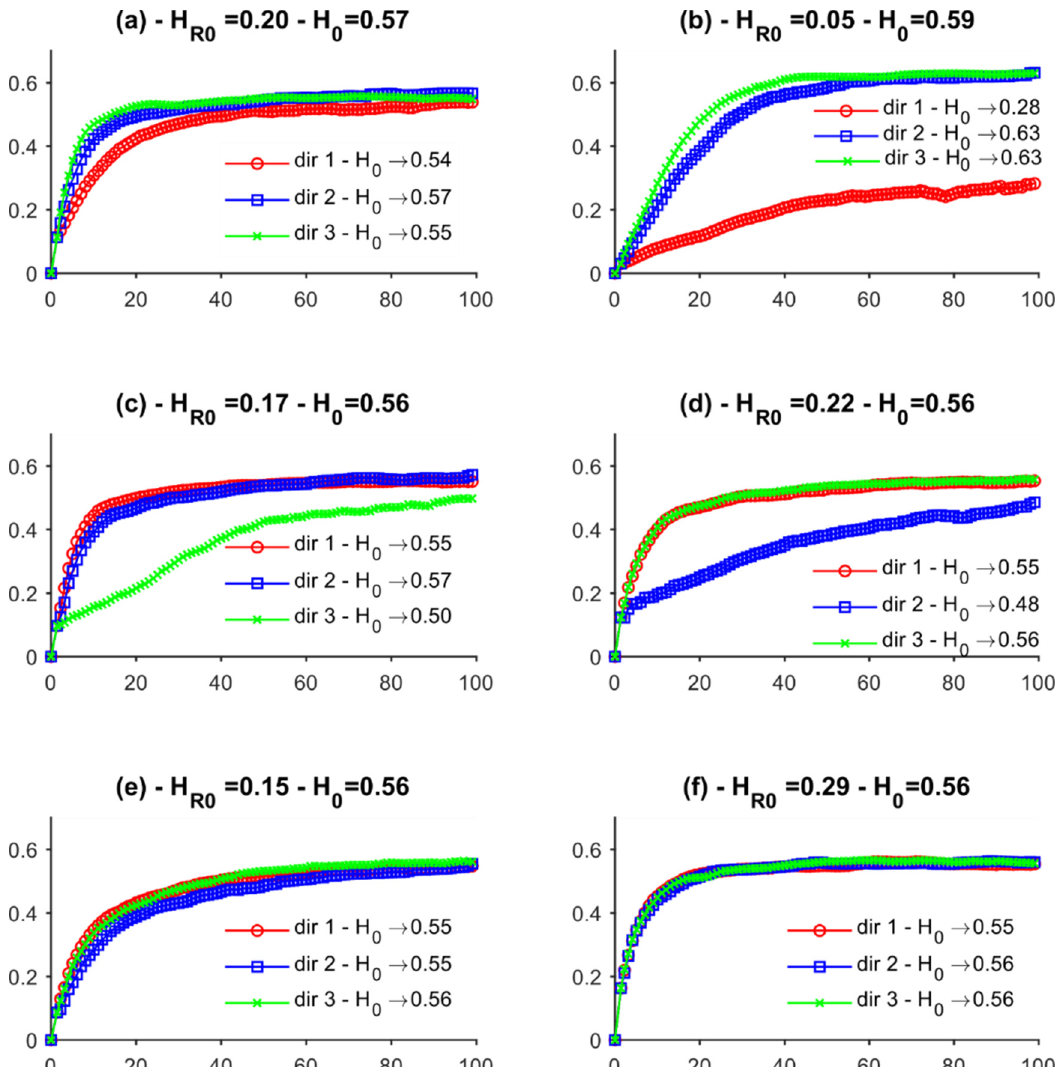
Figure 7. Non-normalised entrograms of the six analysed training images presented in Figure 5. The entrograms calculated with GEOENT (Figure 9) indicate shorter entropic scales